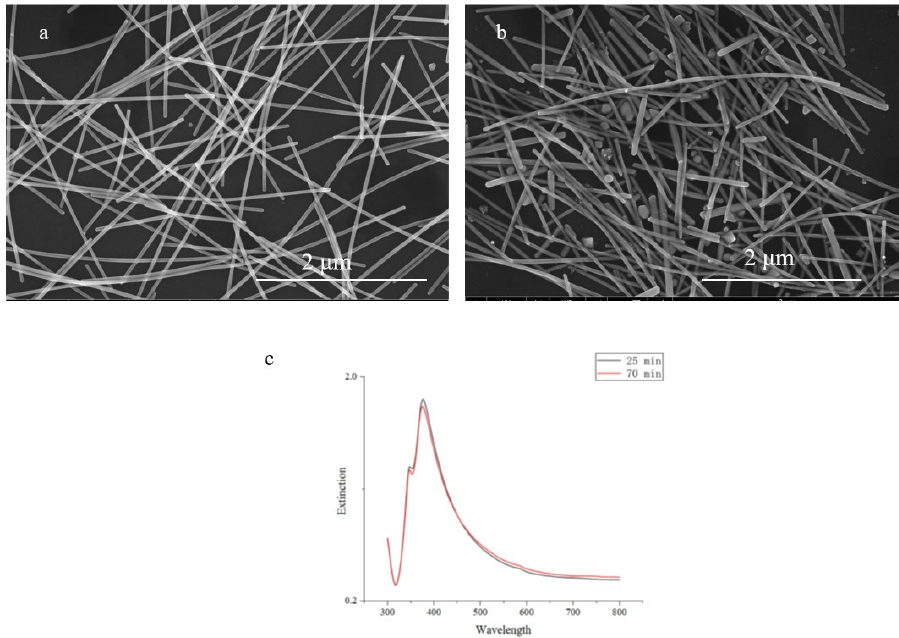
Figure 4. SEM images of AgNWs at 160 °C with TBAC as crystal seed additive at ( a ) 25 min and ( b ) ( b ) 70 min. ( c ) The extinction spectrum at the above 70 min. ( c ) The extinction spectrum at the above times.